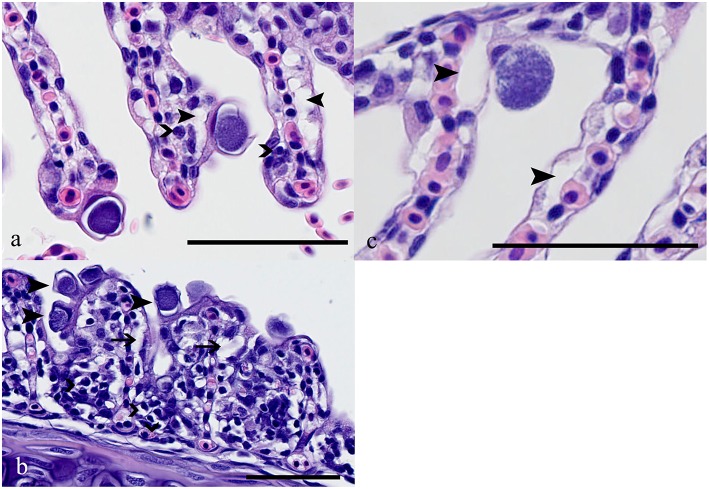
(A) Brown trout (Salmo trutta), gills, Ca. P. salmonis cysts characterized by condensed basophilic intracellular material surrounded by a clear halo; up to 20 μm in diameter. Closed arrowheads indicate edema in the subepithelial area, open arrowheads indicate scattered infiltration with mainly lymphocytes. HE, bar = 50 μm. (B) Ca. P. salmonis cysts (e.g., arrowheads), lamellae showing fusion, infiltration with lymphocytes, macrophages, and eosinophilic granular cells (open arrowheads) and subepithelial edema (arrows). HE, bar = 50 μm. (C) Ca. C. salmonicola cyst characterized by granular loosely arranged material, up to 20 μm in diameter. In the surrounding tissue only scattered edema (closed arrowheads) is visible. HE, bar = 50 μm.